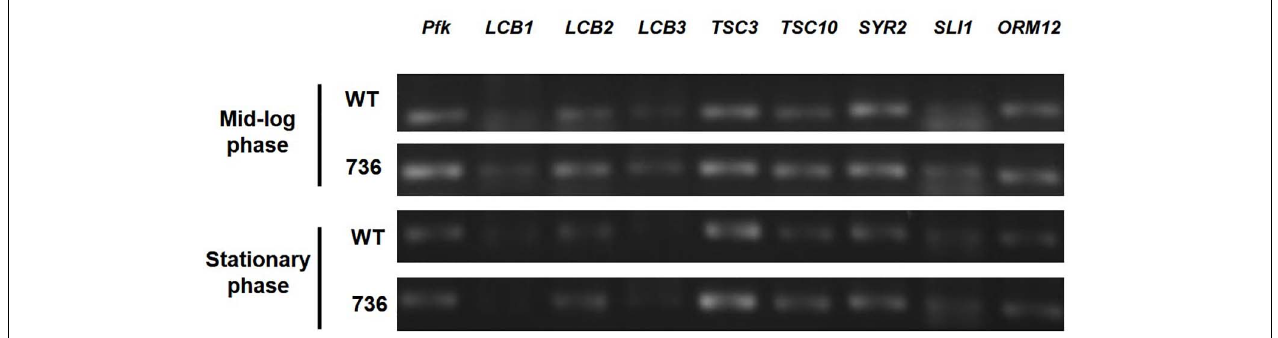
FIGURE 4 | Transcriptional analysis of eight TAPS biosynthesis–related genes in mutant 736 and in the wild-type in mid-log and stationary phases. RT-PCR analysis of eight genes ( LCB1 , LCB2 , LCB3 , TSC3 , TSC10 , SYR2 , SLI1 , and ORM12 ) extracted from the mutant 736 (indicated as 736) and wild-type (indicated as WT) cells in mid-log and stationary growth phases. Housekeeping gene pfk served as the reference.